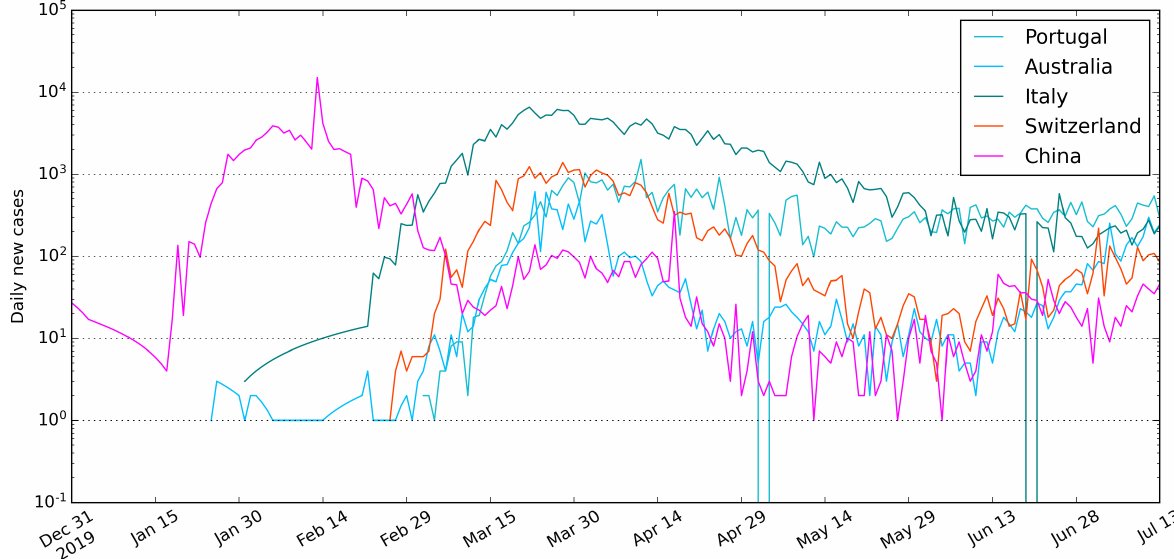
Figure 4. COVID-19 daily cases evolution for attention and impact group countries in log scale. Source Ritchie et al. (2020).